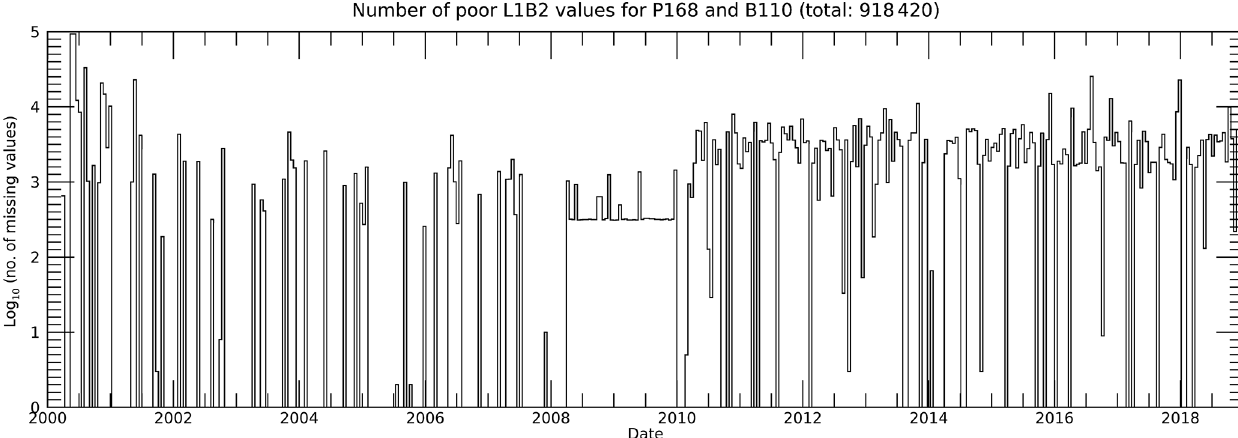
Figure 4. Time series of the logarithm in base 10 of the number of poor pixel values, in this case in the four spectral bands of the nine cameras of B LOCK 110 from each available MISR L1B2 GRP O RBIT in P ATH 168 between late March 2000 and December 2018 (the same B LOCK as in Fig. 3). See the text for a discussion of the similarities and differences between those two time